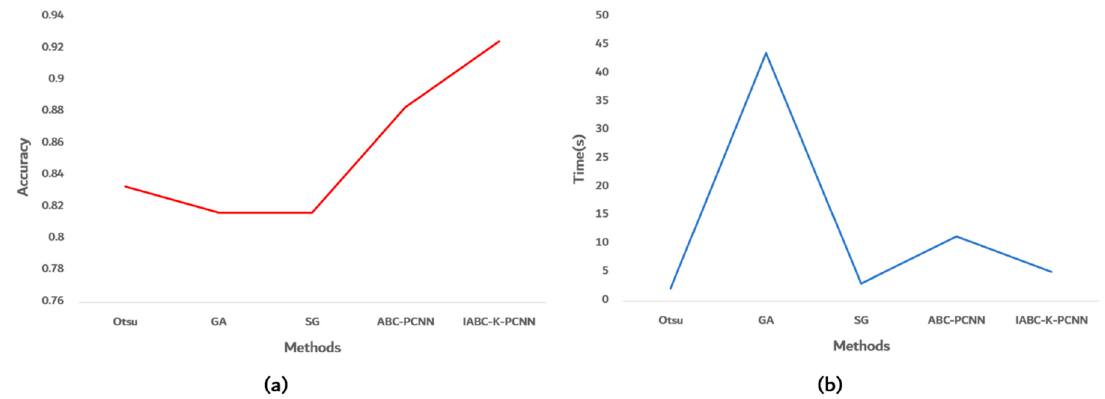
Figure 11. Disease spot segmentation results. ( a ) Classification accuracy of each method, ( b ) classification time of each method.